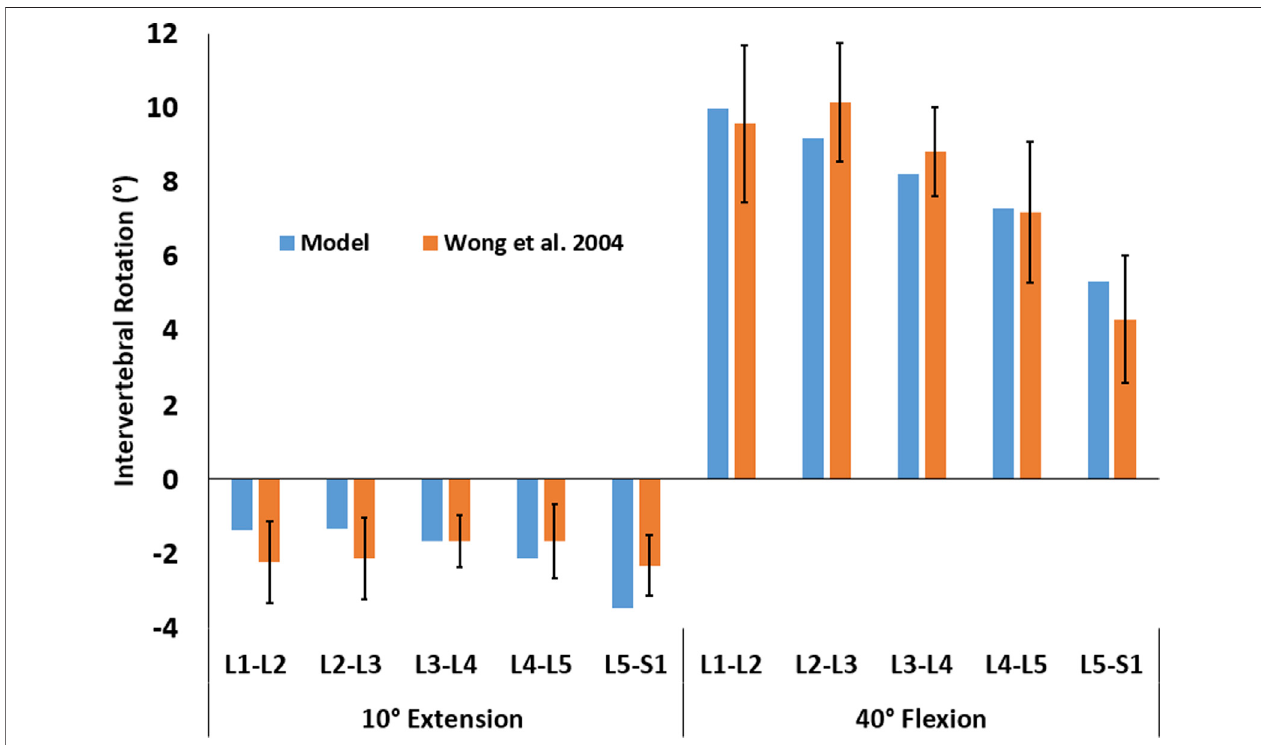
FIGURE4 | Intervertebral rotations for twoactivitiesof 10 ° extension and 40 ° fl exion were predicted bythe model (blue) and observed in 50 male subjects(orange, Wong et al., 2004). The error bars represent the mean ± one standard